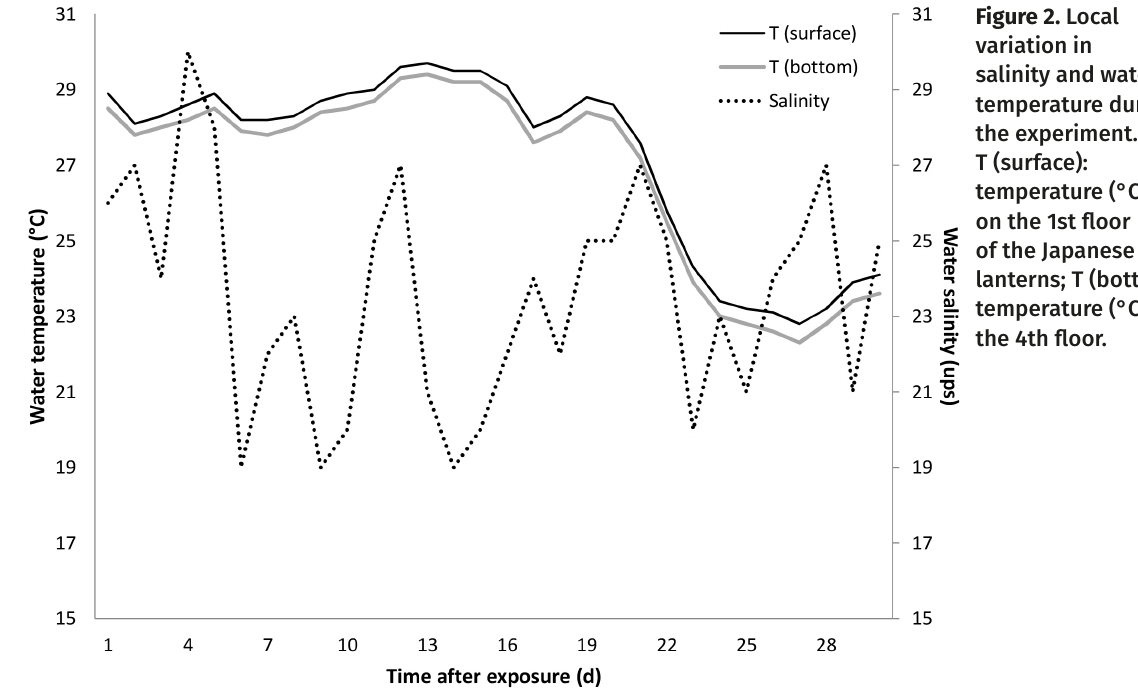
Figure 2. Local variation in salinity and water temperature during the